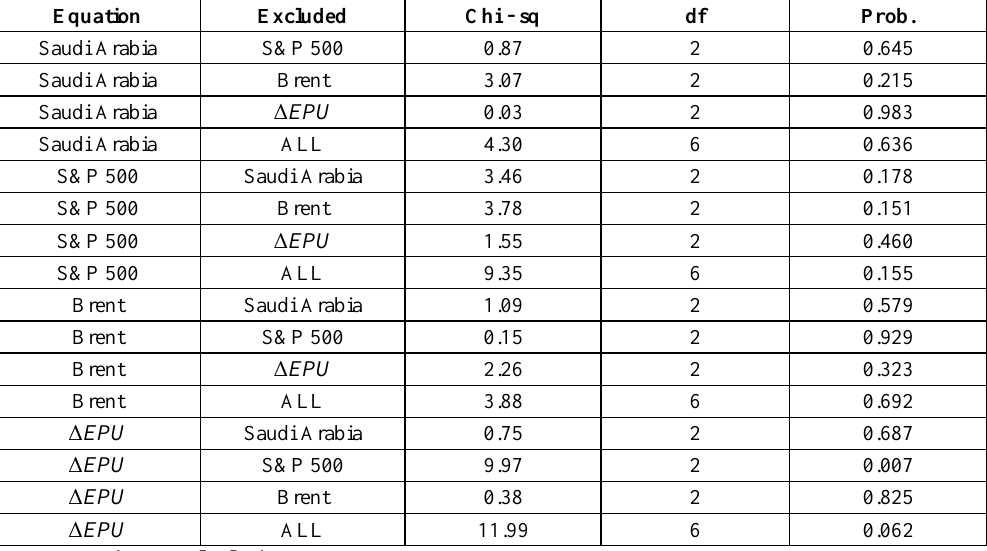
Table 9. Granger Causality Wald Tests